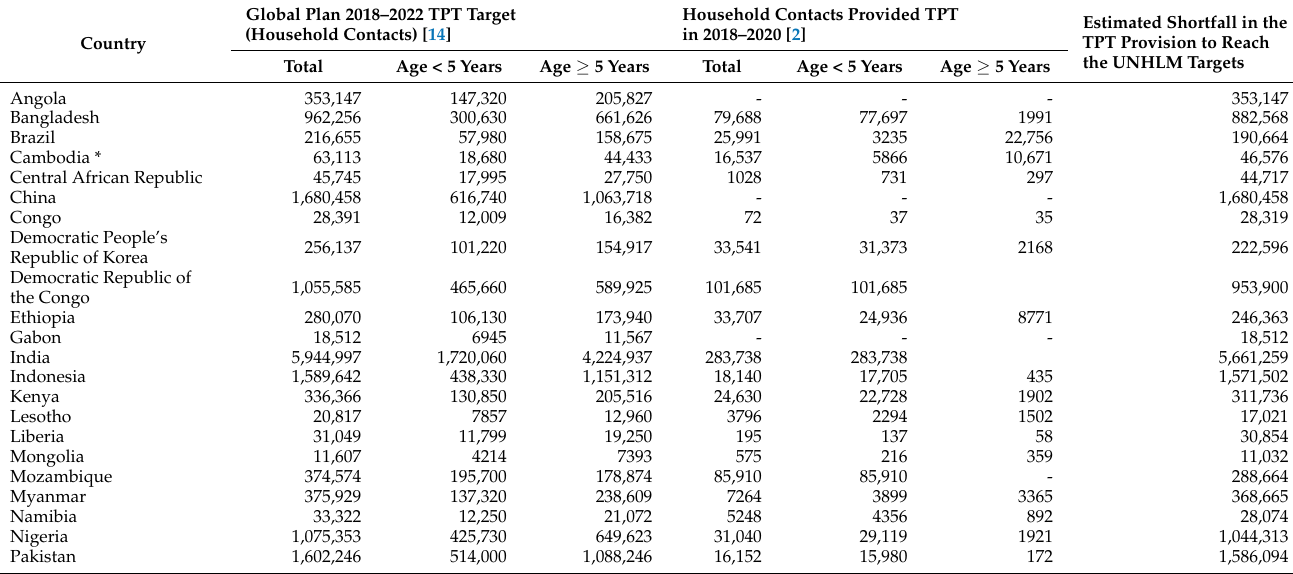
Table 2. Countries’ TB preventive treatment (TPT) targets and the estimated number of household contacts to be provided TPT to achieve UNHLM TPT targets for 30 high-TB burden countries and 3 countries on the global TB